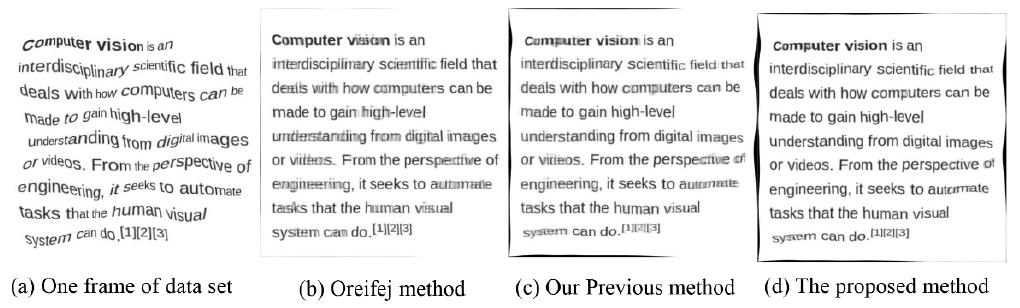
Figure 7. The result comparison between the proposed method and other registration strategies. ( a ) One frame of the original data set. ( b ) The result recovered by the Oreifej method. ( c ) The result recovered by our previous method. ( d ) The result recovered by the proposed method.